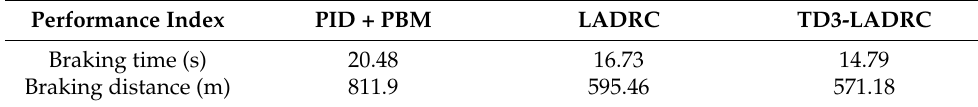
Figure 8. ( a ) Extended state of TD3-LADRC; ( b ) controller bandwidth ω c ; ( c ) controller bandwidth ω o . Table 8. AABS performance